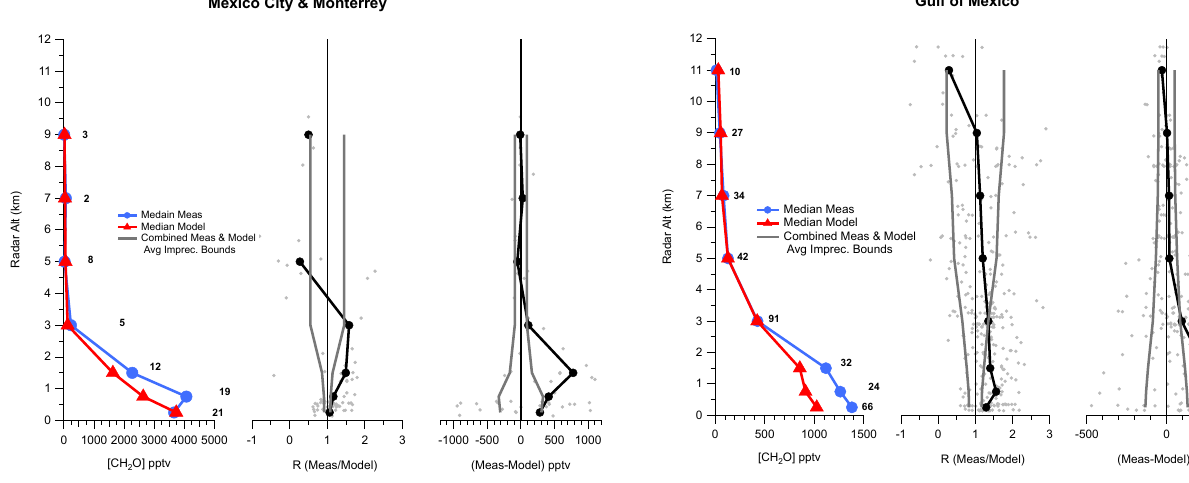
Fig. 7. Time coincident comparisons on hydrocarbon time base over the Gulf of Mexico during the 1st phase of INTEX-B. This plot has the same format as Fig. 5. The combined imprecision limits could not be determined for the 10–12km bins (only 1 data point) and the values for the 8–10km bins are repeated for that bin.